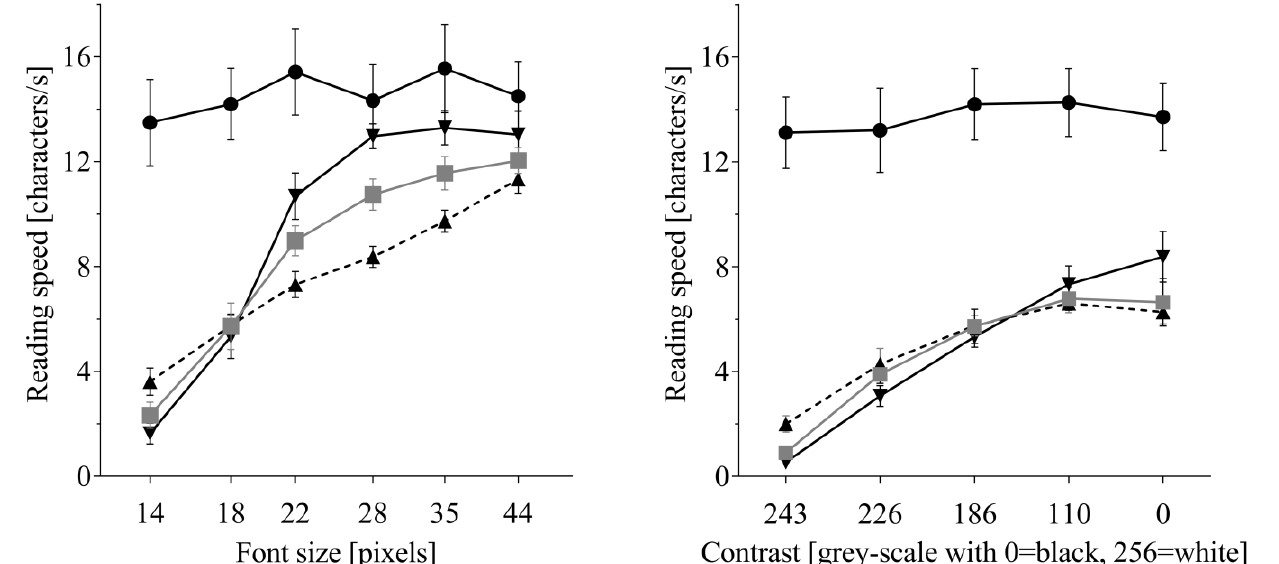
Figure 2. The effect of magnification on reading speed. Figure 3. The effect of contrast enhancement on reading speed .